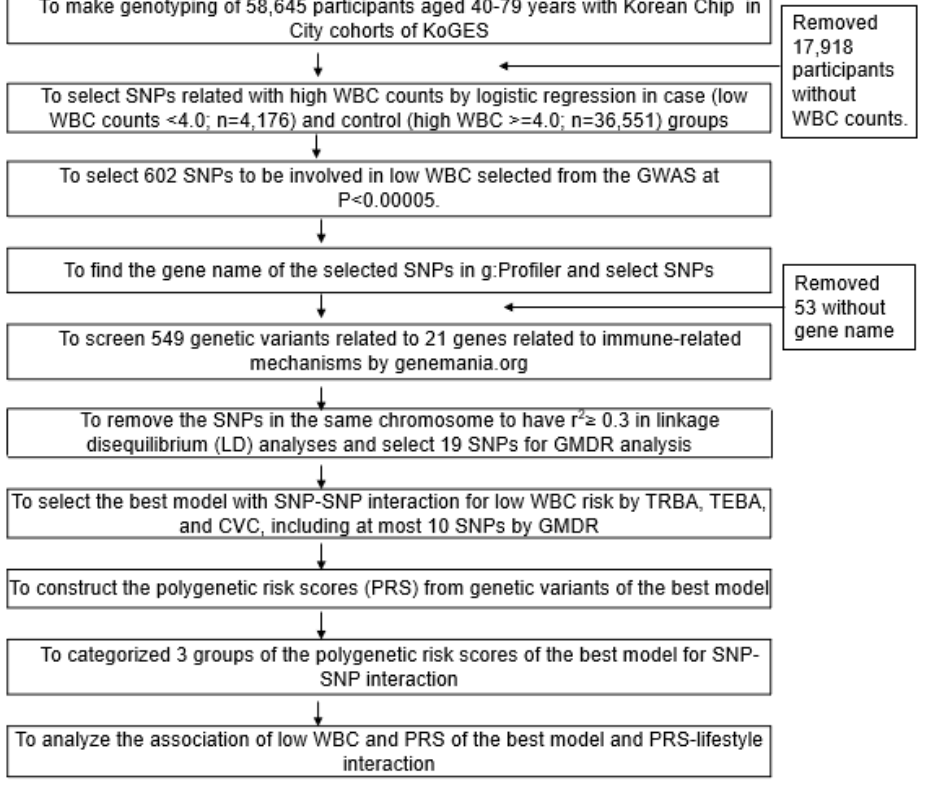
Figure 1. Flow chart for the generation of polygenetic variants increasing the risk of a low white blood cell (WBC) count and interactions between polygenetic risk scores (PRS) and